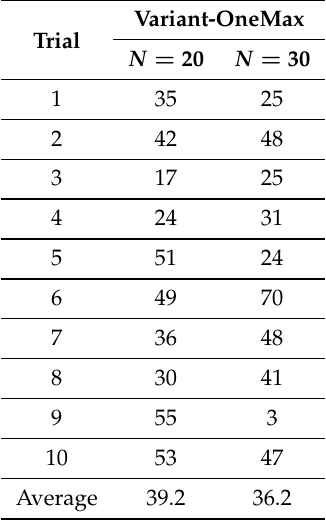
Table 4. Experimental results on the Variant-OneMax Problem [41].